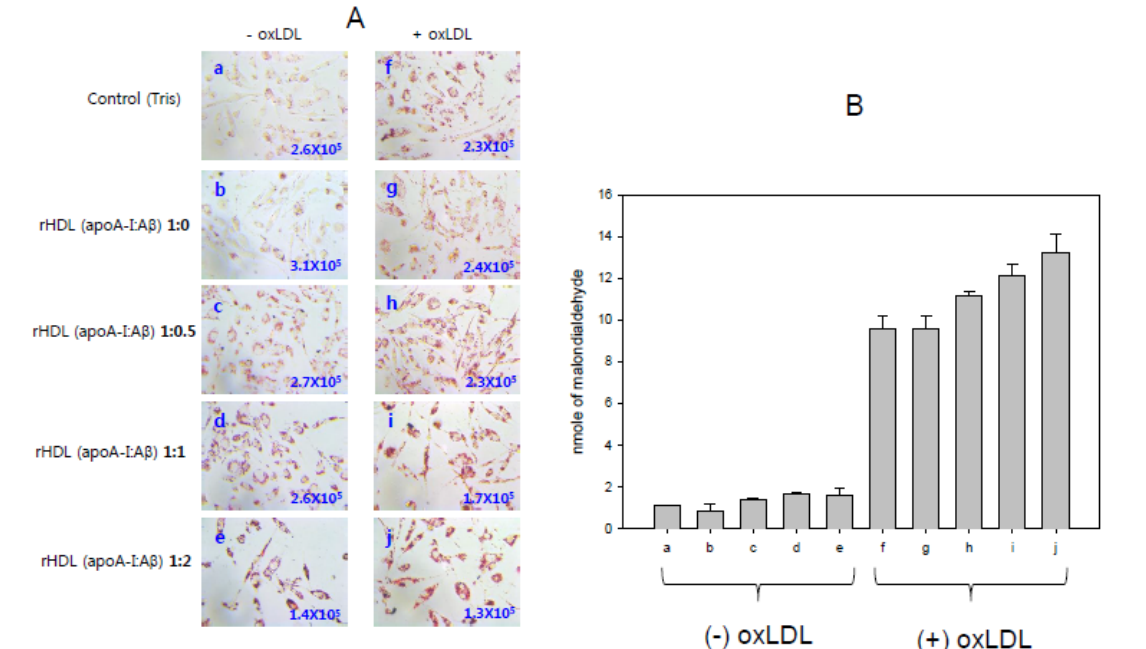
Figure 7. Phagocytosis of oxLDL into macrophages in the presence of rHDL containing apoA-I and A β . Lipid accumulation was visualized by Oil–red O staining ( A ). Quantification of oxidized species in the cell media by a TBARS assay ( B ).